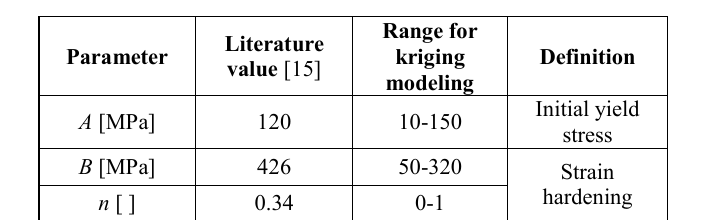
Table 2. Simulation parameters.